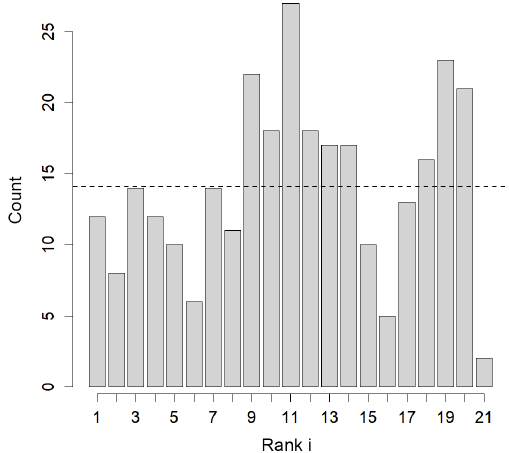
Figure 8. Rank histogram relative to the 20-model ensemble for the Caldogno application